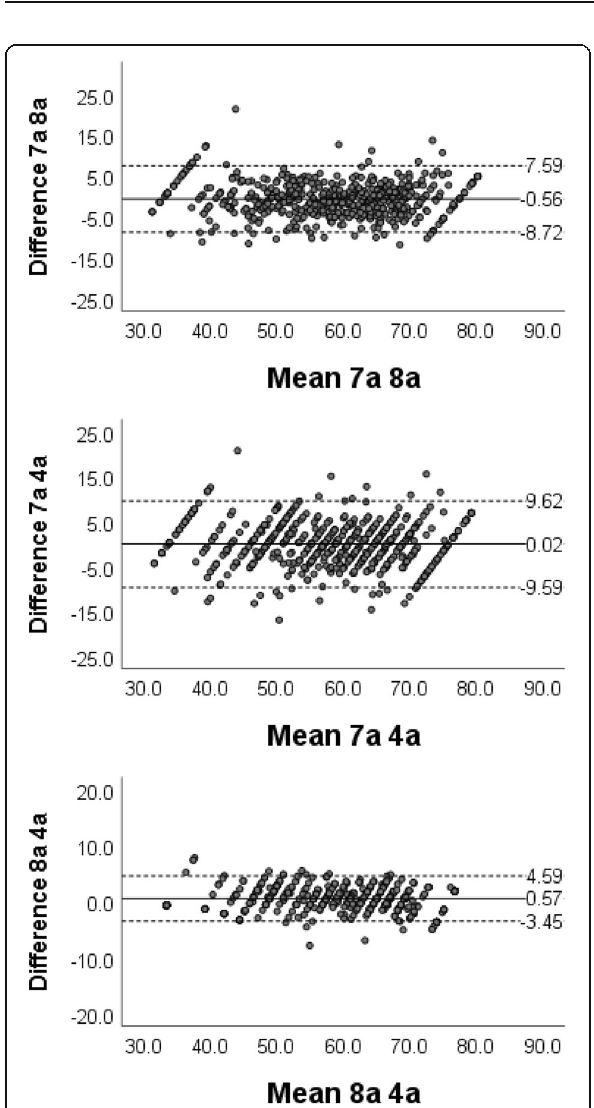
Fig. 2 Bland-Altman plot showing correspondence between scores of PROMIS Fatigue short forms. Lines represent average difference and ± 1.96 standard deviation of the